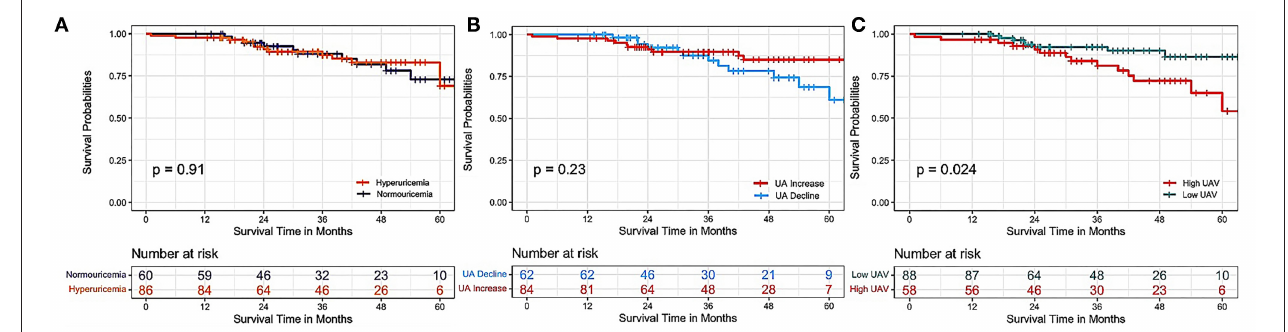
FIGURE 4 | Kaplan–Meier survival curves according to serum UA levels at first follow-up and their variability with respect to baseline levels. (A) Kaplan–Meier survival curves of patients with hyperuricemia and normouricemia according to the uric acid levels re-evaluated at the first follow-up ( p = 0.91). (B) Kaplan–Meier survival curves of patients with an increase or decline in serum UA levels at first follow-up compared with baseline UA levels ( p = 0.23). (C) Kaplan–Meier survival curves of patients with a high or low variability of change in serum UA levels at first follow-up compared with baseline UA levels ( p = 0.024). UAV, uric acid